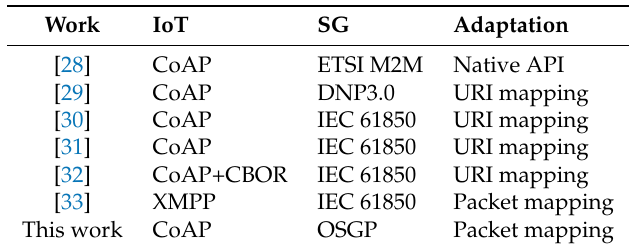
Table 1. Related